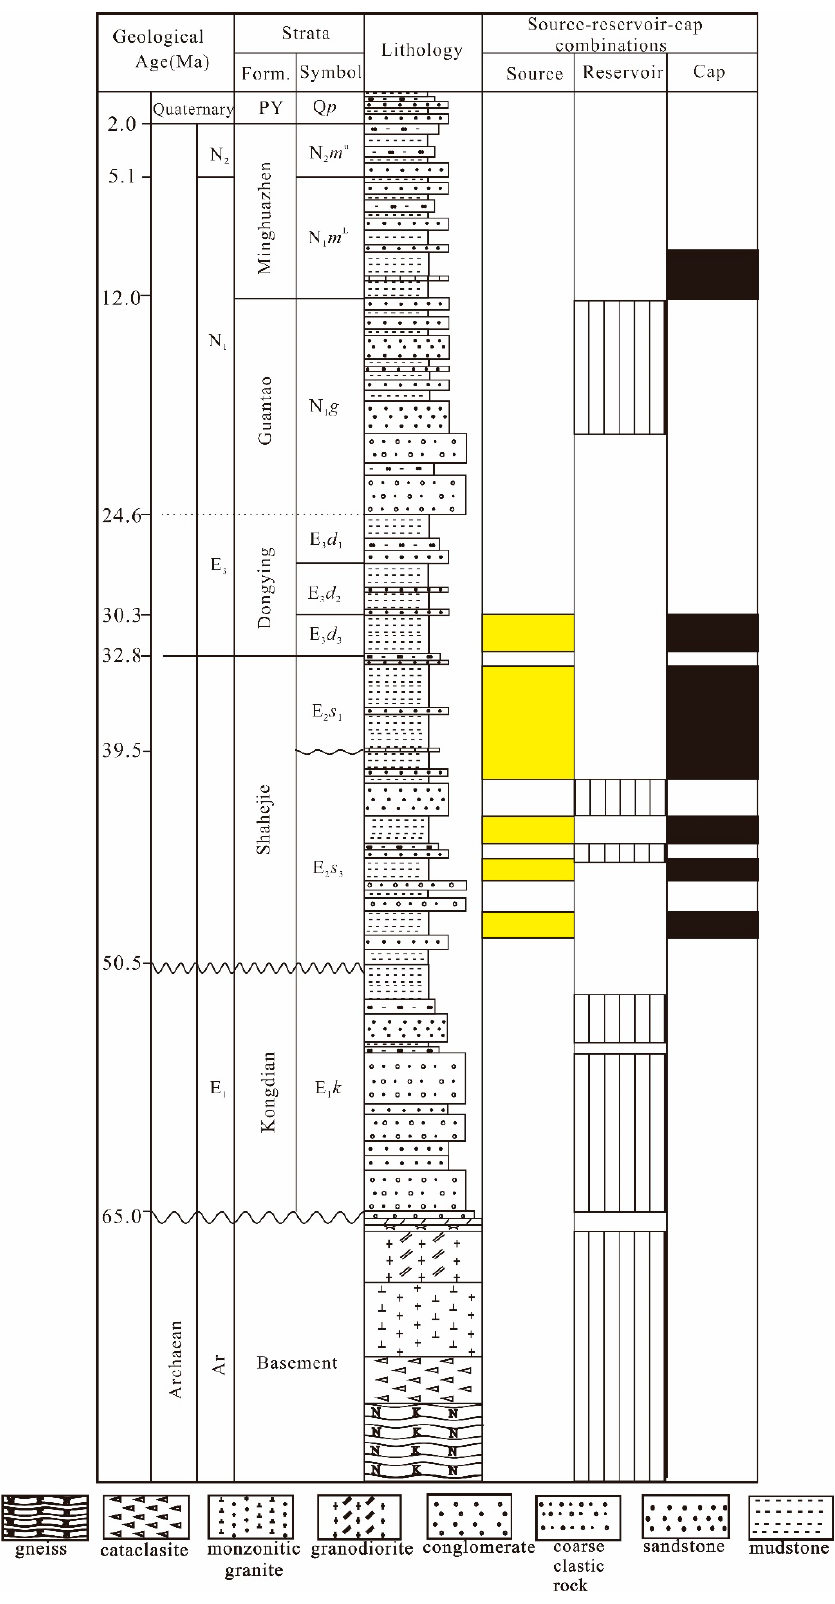
Figure 2. Stratigraphic column of Bohai Bay Basin showing the lithologies and the source–reservoir– cap combinations. The study interval is the Paleocene Kongdian Formation.